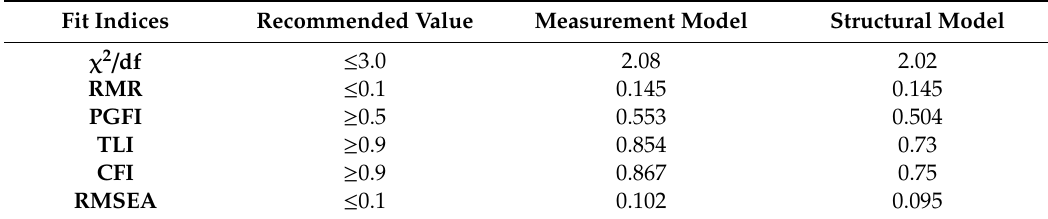
Table 8. Fit indices for research